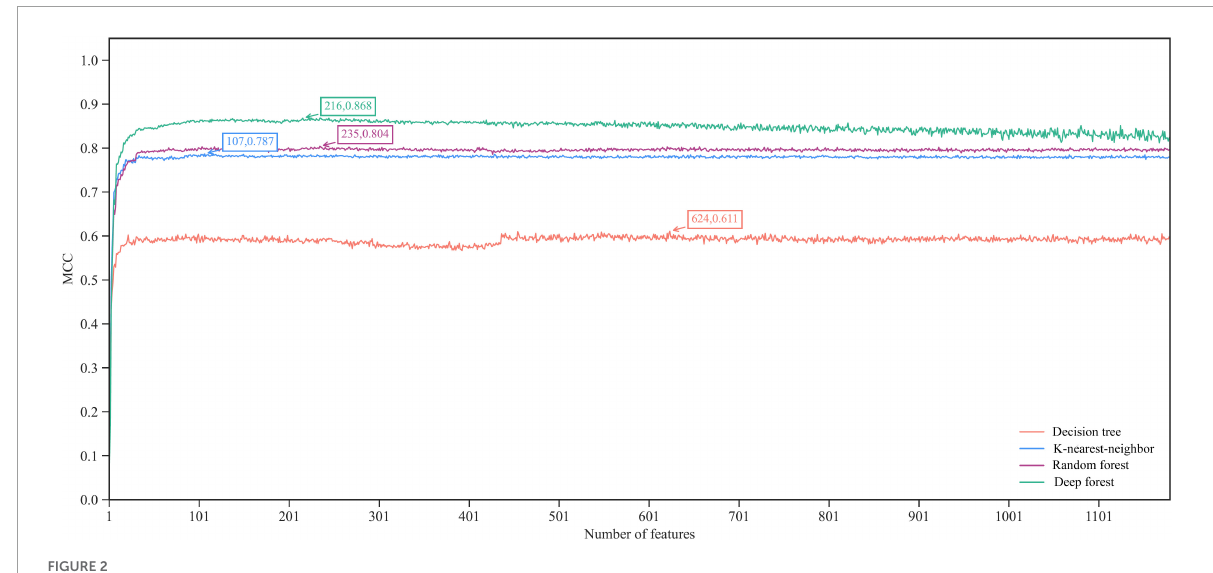
TABLE 2 Performance of the optimal classifiers with different classification algorithms on the training and test datasets. Classification algorithm Number of features Training dataset Test dataset ACC MCC ACC MCC